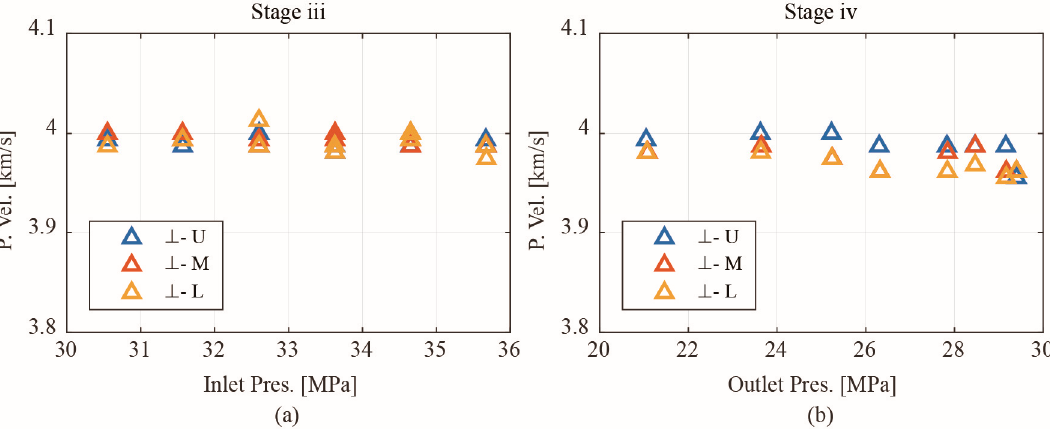
Figure 10. Comparison of measured v P in stage iii ( a ) and iv ( b ); ⊥ -U, ⊥ -M, and ⊥ -L indicates the wave traces at the upper, middle, and lower positions of the sample, respectively.